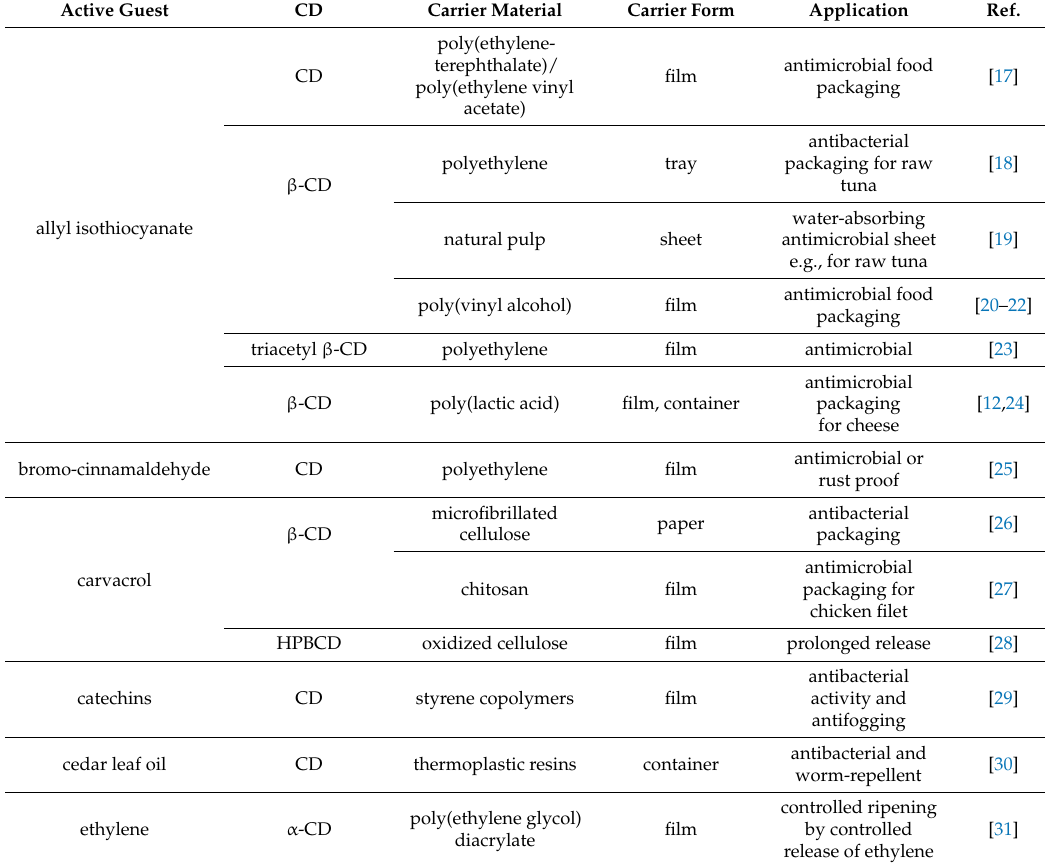
Table 1. Cyclodextrin containing packaging